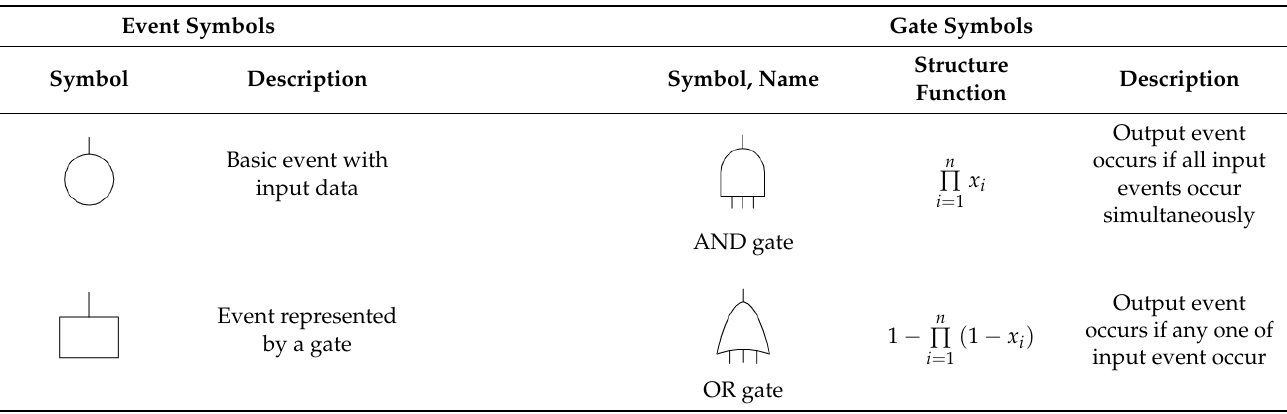
Table A1. Event and gate